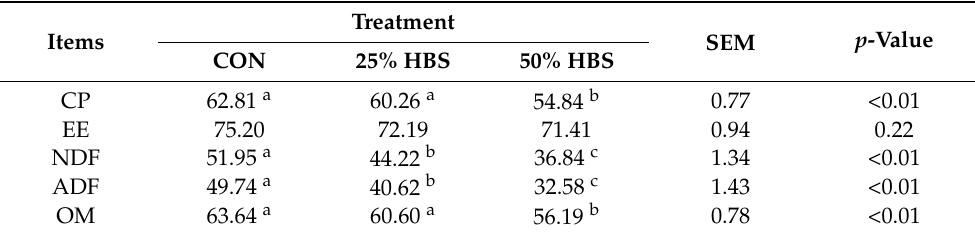
Table 3. Effects of different proportions of hydroponic barley seedlings replacing oat hay on nutrient digestibility of heifers.